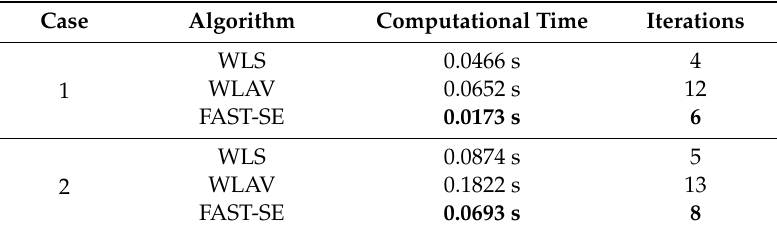
Table 2. The comparison of computational e ffi ciency.